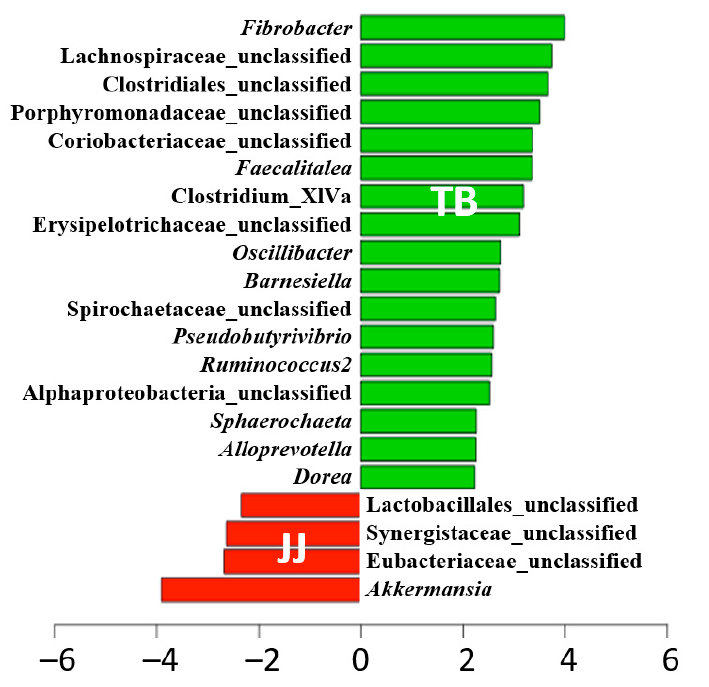
Figure 4. Differentially abundant bacteria based on the LEfSe analysis for Jeju and Thoroughbred horses. JJ; Jeju horse, TB; Thoroughbred horse.